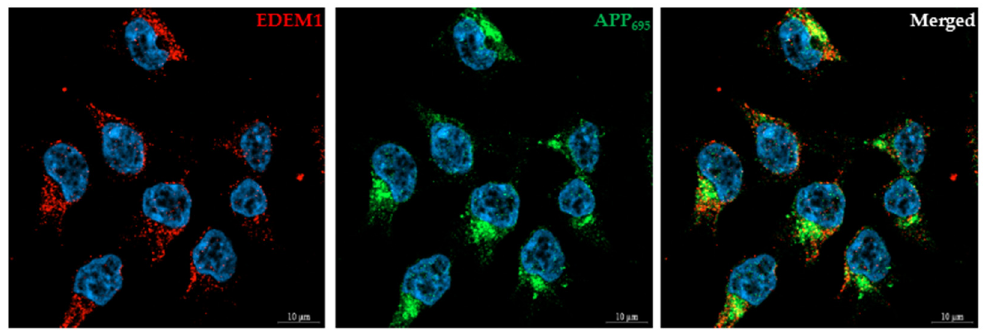
Figure 8. EDEM1 colocalizes with APP in HEK293 cells. Cells were transfected with APP 695 and EDEM1, and were then fixed and stained as indicated. DAPI was used to stain the nuclei. Bars, 10 µm. Control staining without anti-APP or anti-EDEM1 antibodies confirmed specific recognition by secondary antibodies.